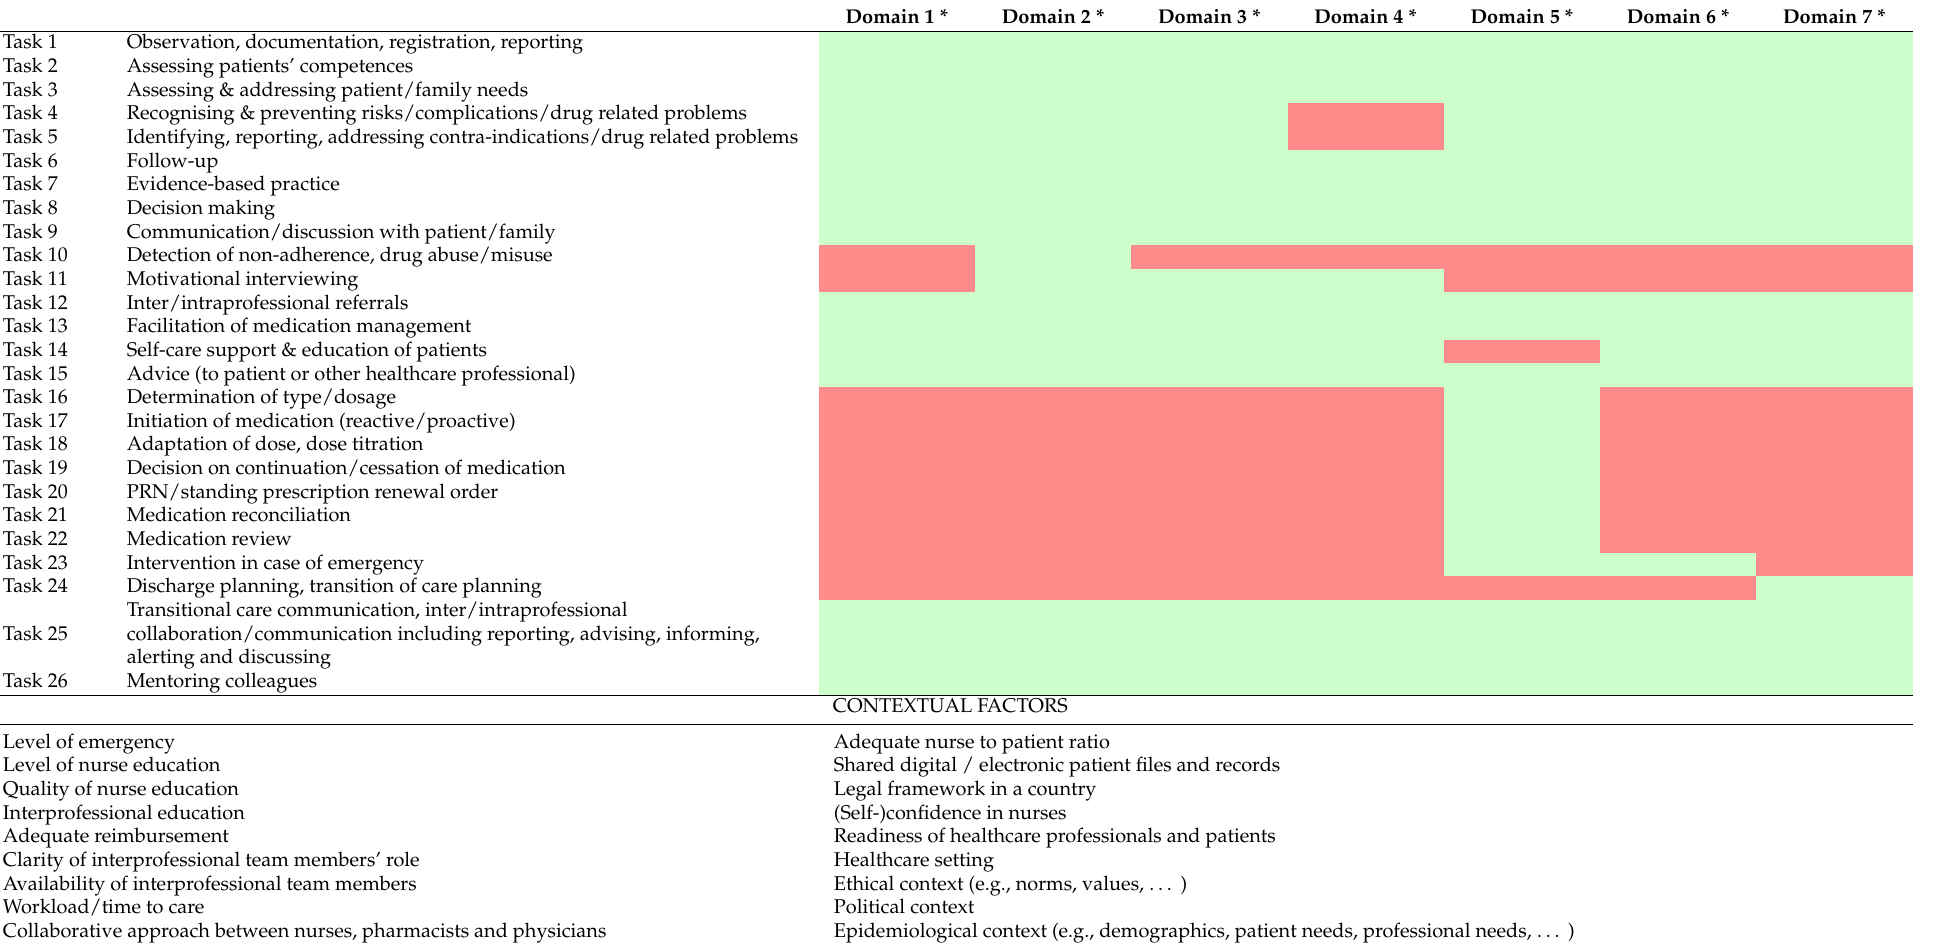
Table 1. Overview of 26 potential tasks within 7 pharmaceutical care domains, and 20 contextual factors, for nurses in interprofessional pharmaceutical care, extracted from previous DeMoPhaC studies [33–35]. Colors indicate whether the task was part of a pharmaceutical care domain (green) or not